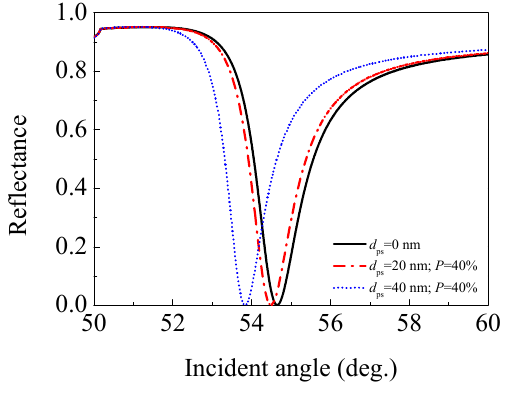
Figure 5. The angular spectra of the SPR sensors with 0 (traditional SPR sensor), 20, and 40 nm thick 40% porosity porous silica film ( n ps = 1.270). Table 2. The performance parameters of the SPR sensors with 0 (traditional SPR sensor), 20, and 40 nm thick 40% porosity porous silica film ( n ps = 1.270).